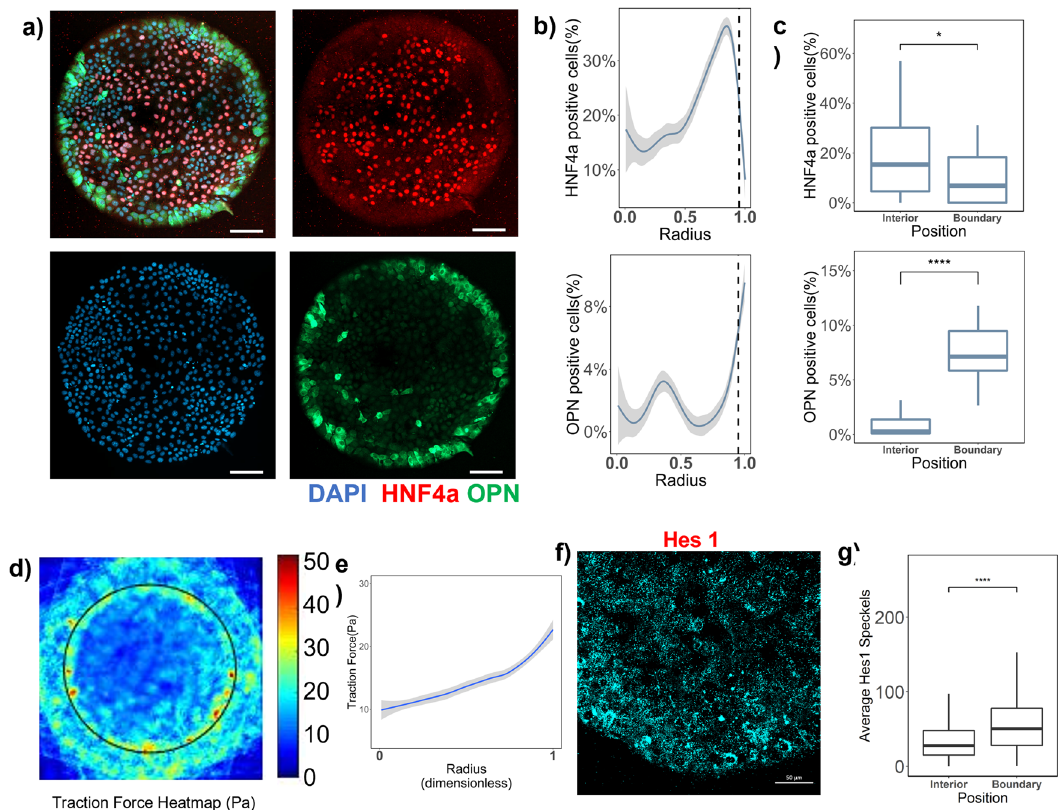
Fig. 1 Patterned liver progenitor differentiation, cellular forces, and Notch signaling. a Representative fl uorescent Images of BMELs on Col 1 microarrays on 25 kPa polyacrylamide hydrogels. Red: HNF4a, Green: OPN, Blue: DAPI. Scale Bar: 100 μ m. b Quanti fi cation of average percent HNF4a + and OPN + cells/island as a function of the radius. 0 is center, 1 is the edge, vertical dashed line at radius = 0.95. c Quanti fi cation average percent HNF4a + and OPN + cells/island in the interior (radius = 0 – 0.95) and at the boundary (radius = 0.95 – 1.00). d Traction force heatmap for BMELs on circular islands, blue (low traction) to red (high traction). e Traction force (Pa) of BMELs on circular microarrays as a function of the radius. f ISH-HCR quanti fi cation of Hes1 mRNA, 40X confocal maximum intensity projection of BMELs on circular islands. g Quanti fi cation of average Hes1 mRNA speckles on the boundary versus the interior. Boxplots: * p -value < 0.05; **** p -value < 0.0001, calculated using Wilcox test in R, Line plots — gray is the 95% con fi dence interval. n ≥ 4 biological replicates (independent experiments) and n ≥ 15 technical replicates (individual